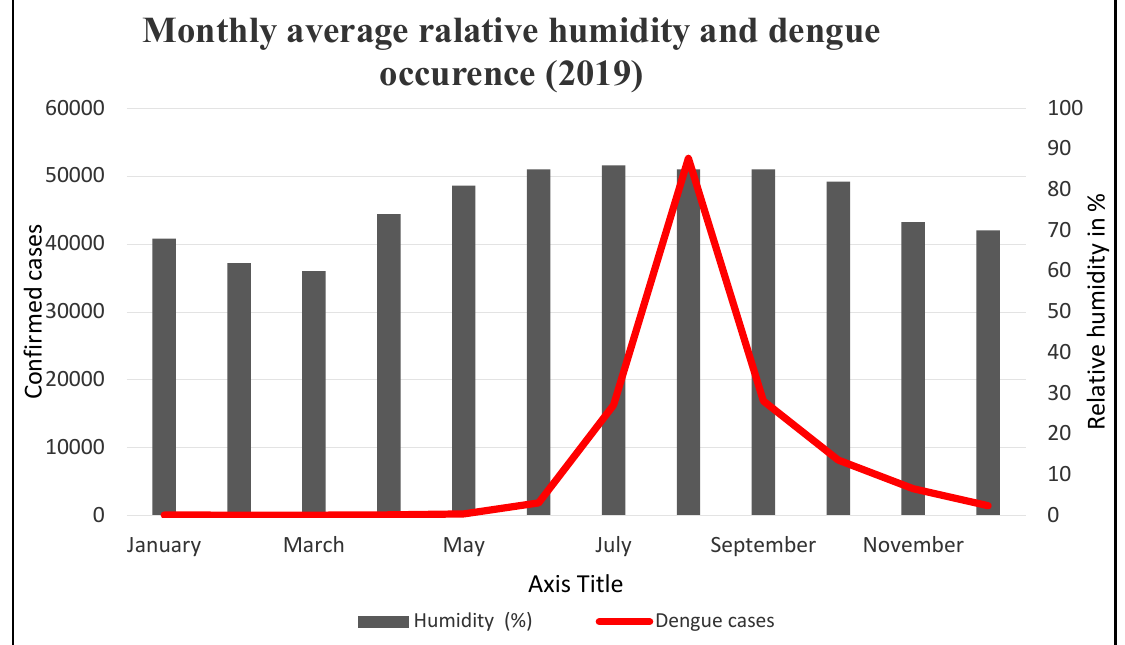
Figure 6. Monthly average relative humidity and dengue cases (1000x) in Dhaka (2019). Monthly average rainfall: The tropical climate is hot, damp, and humid in